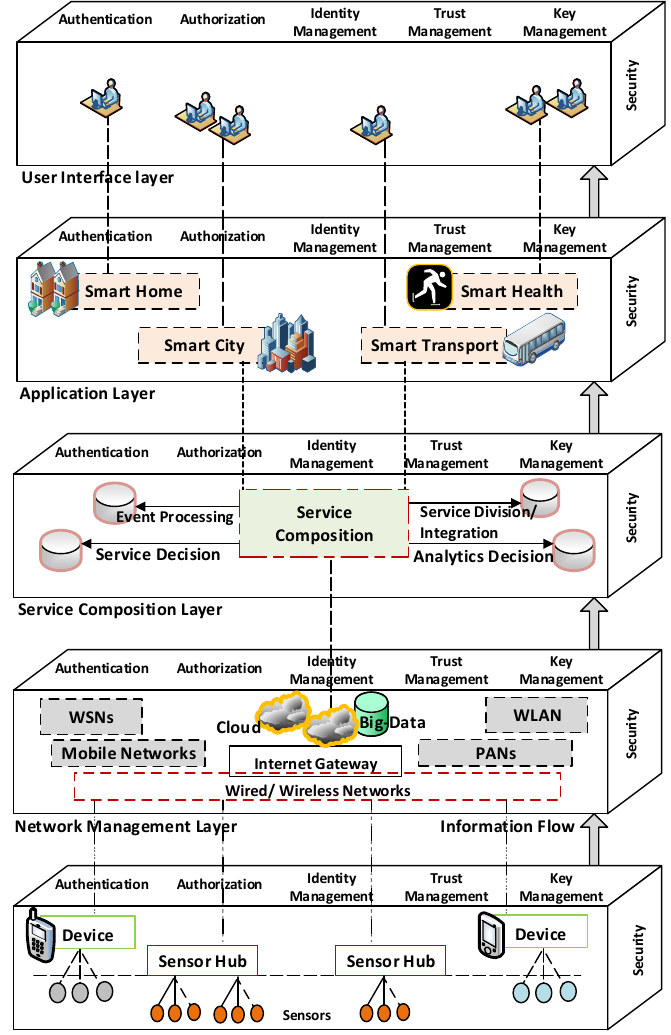
Figure 1. The functional layers of an IoT security